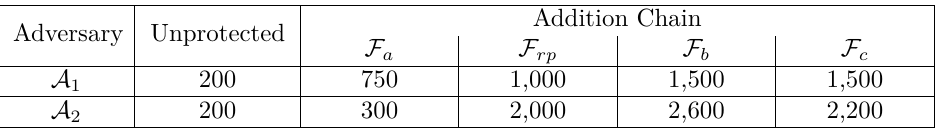
Figure 11: The combined results of second-order CEMA on four typical masked addition chain implementations. Table 3: Comparison of the number of required traces for electromagnetic analysis to reach a GE lower than 10 for different addition chain